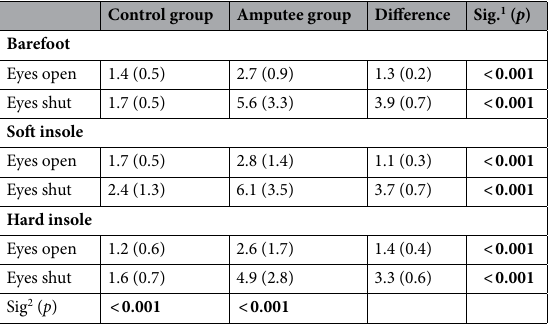
Table 5. Comparison of lateral velocity between experimental groups. Significant values are in [bold]. Mean (standard deviation). 1 Mann–Whitney Test. 2 Friedman Test. Lateral velocity (mm/sg).